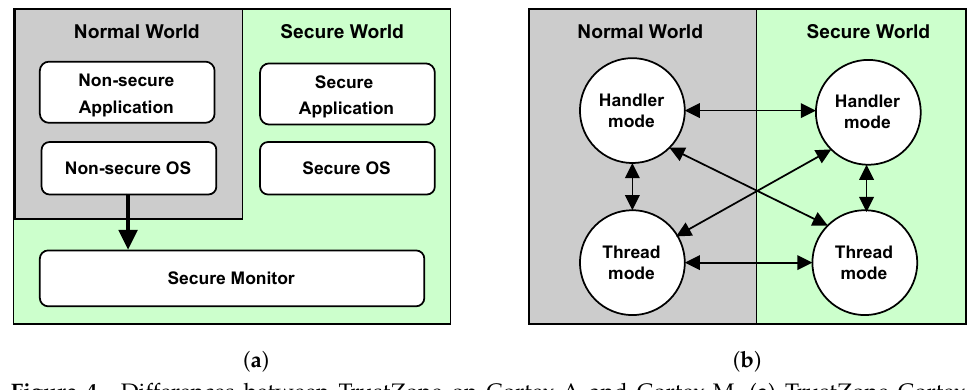
Figure 4. Differences between TrustZone on Cortex-A and Cortex-M. ( a ) TrustZone Cortex-A. ( b ) TrustZone